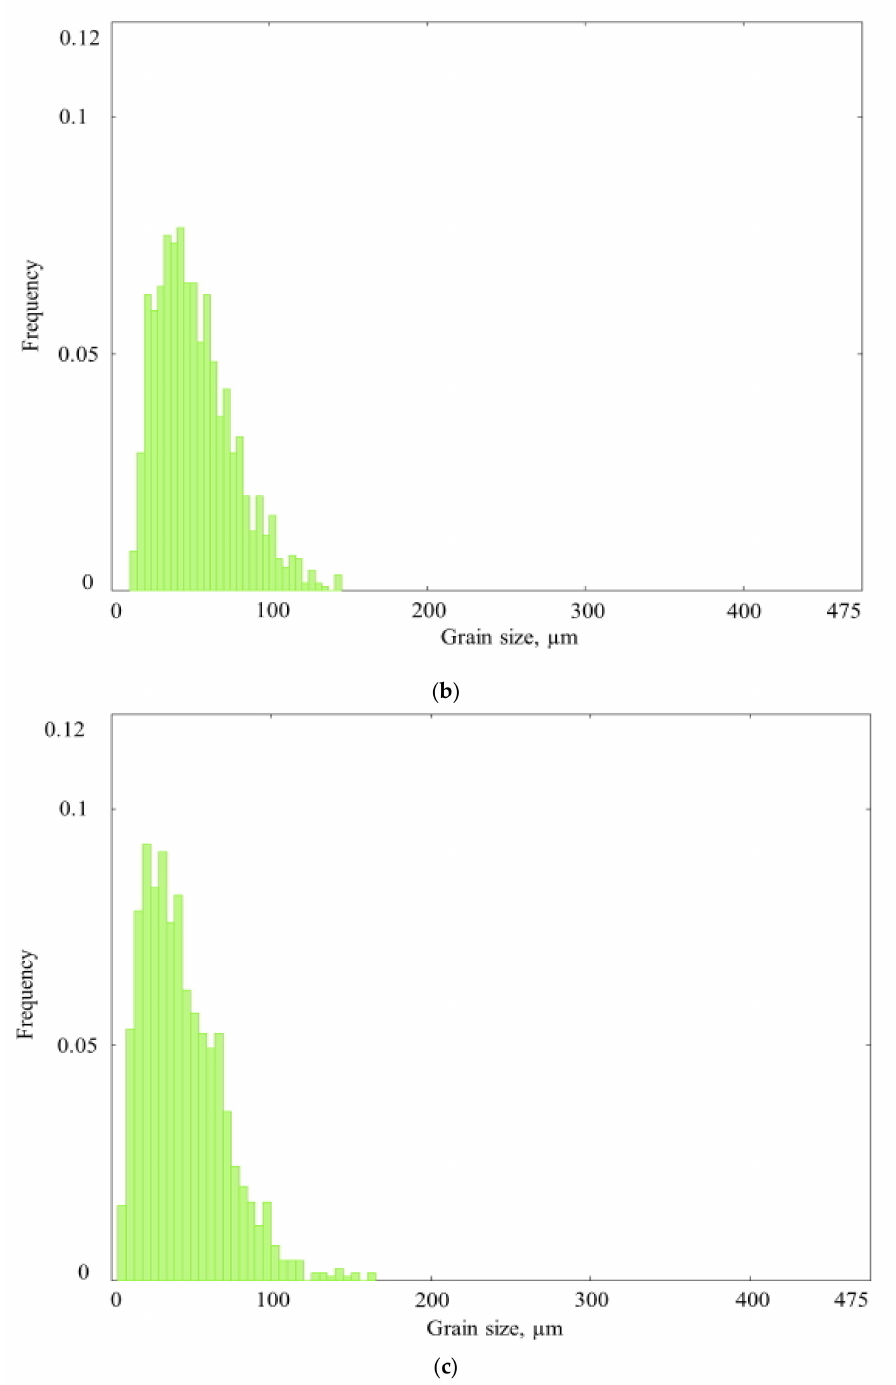
Figure 2. Histograms of the grain size distribution of the reference billet ( a ) after two-high screw rolling, and ( b ) three-high screw rolling ( c